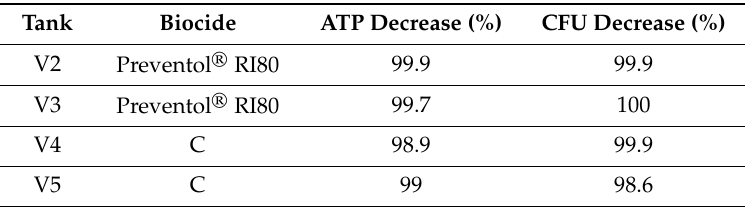
Table 8. Percent decrease of the amount of ATP and colony forming units (CFU) after the biocidal